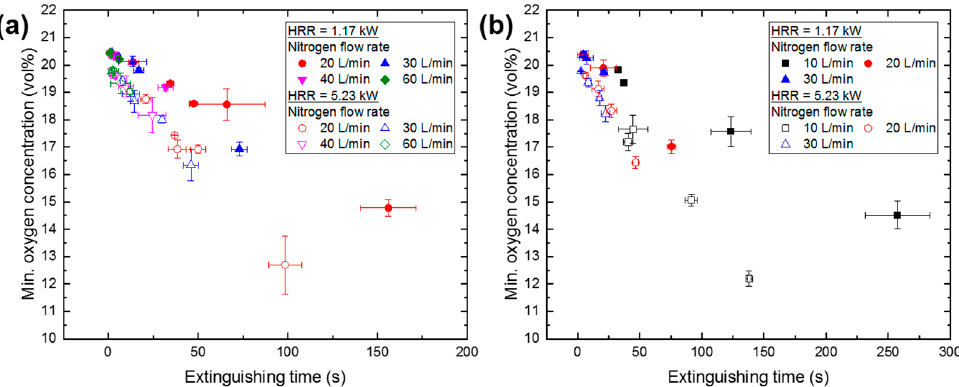
Figure 8. Extinguishing time vs. minimum oxygen concentration for discharge area effect (note that the scales of x -axis in both figures are different): ( a ) large atomizer and ( b ) small